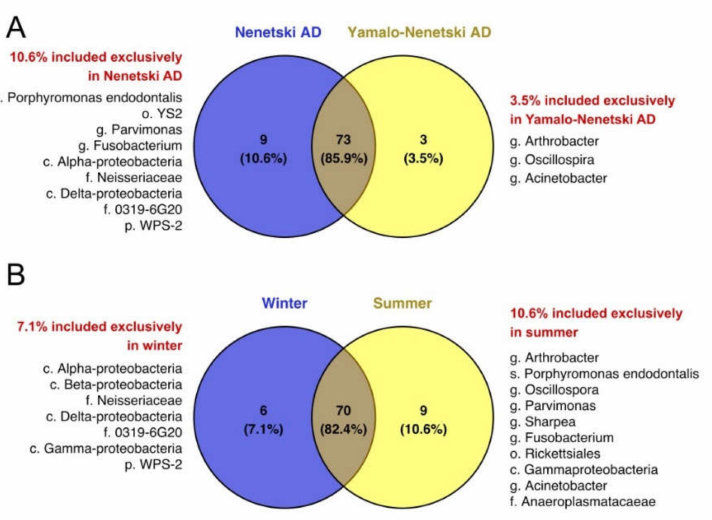
Figure 5. Venn diagram analysis of the diversity of the ruminal bacterial population in reindeer: comparisons of regions ( A ) and seasons ( B